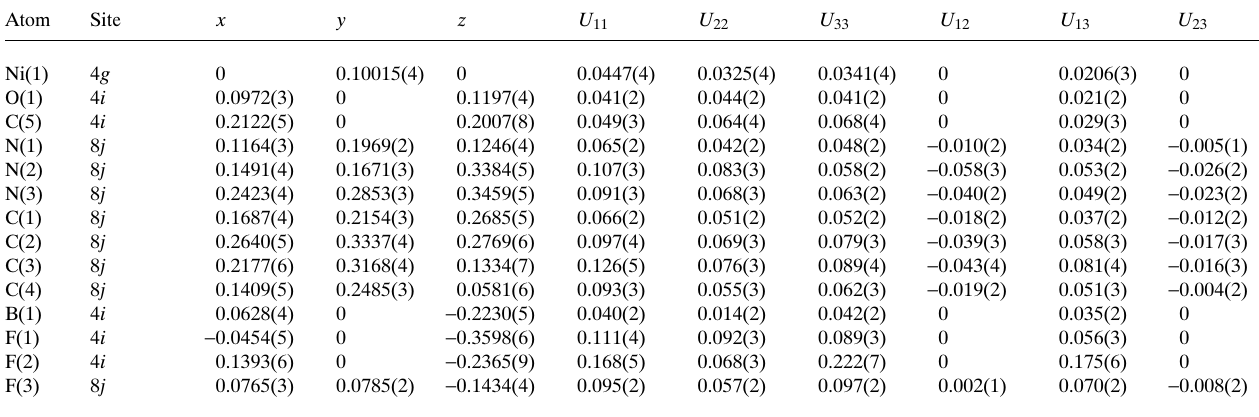
Table 3. Atomic coordinates and displacement parameters (in Å 2 )